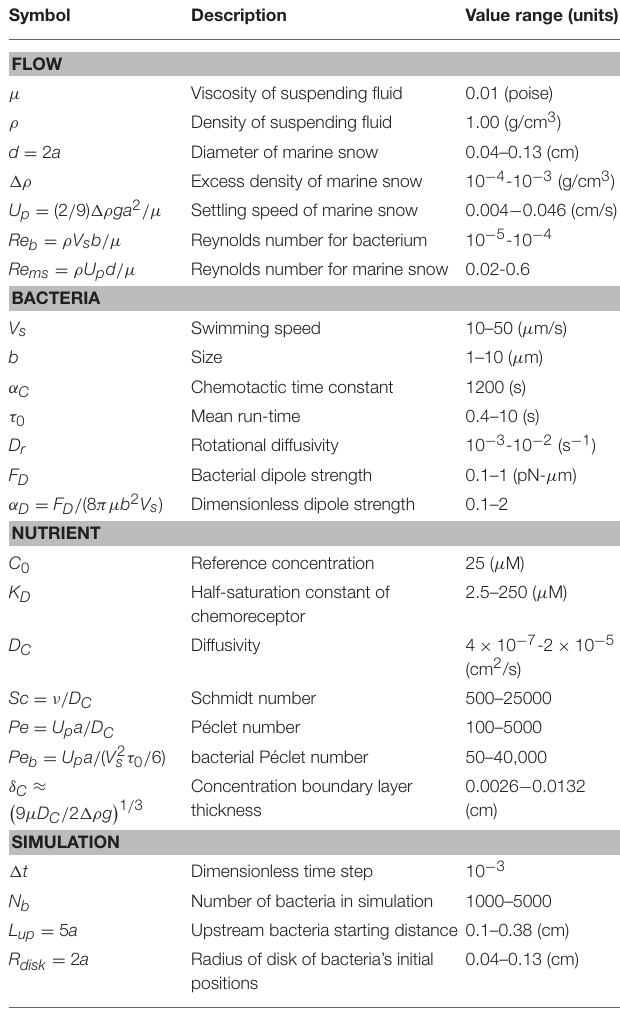
TABLE 1 | List of parameters and their values used in the numerical